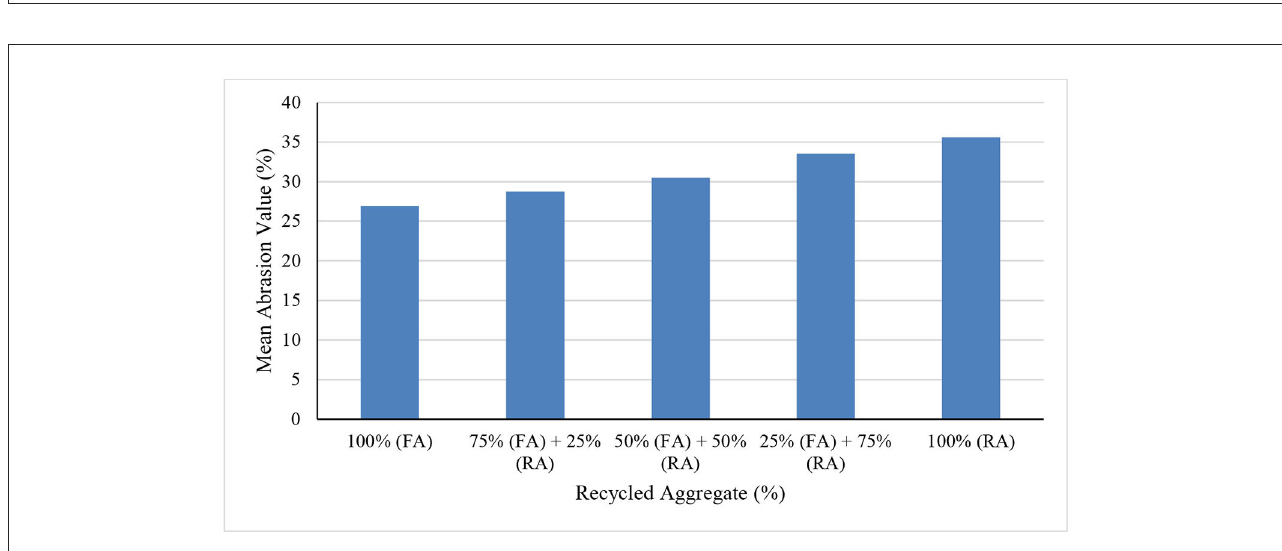
FIGURE6 Recycled aggregates abrasion value at different percentages of replacement.